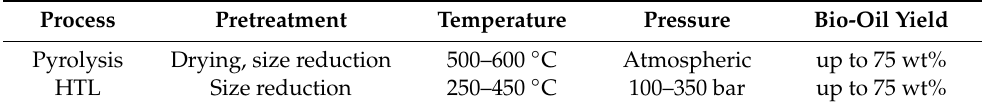
Table 3. Thermochemical conversion methods for bio-oil production [8,33]. HTL, hydrothermal liquefaction.